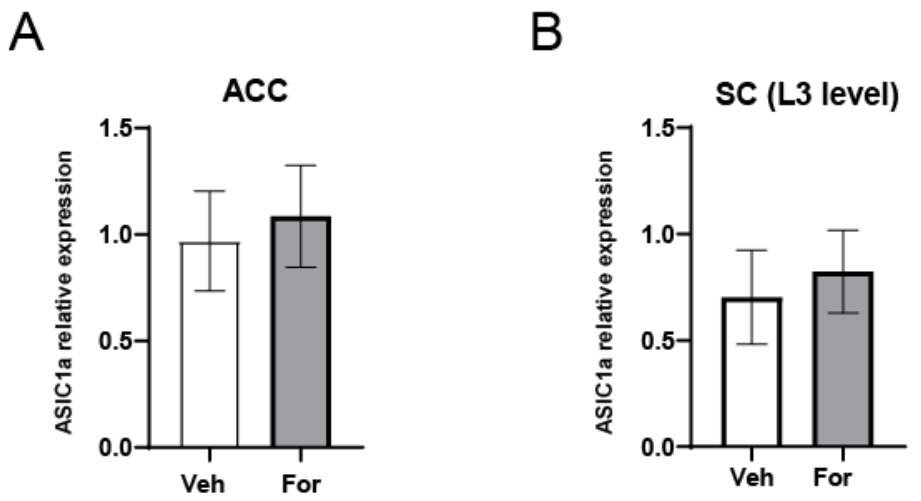
Figure 4. ASIC1a mRNA levels in the pain pathway. ( A ) Plots of ASIC1a mRNA levels in ACC contralateral regions injected with formalin or vehicle (PBS). ( B ) Plot of ASIC1a mRNA levels in the L3 segment of the SC in formalin or PBS injected animals. Two-tailed unpaired t-test (experiments in technical triplicates; four animals used per condition).